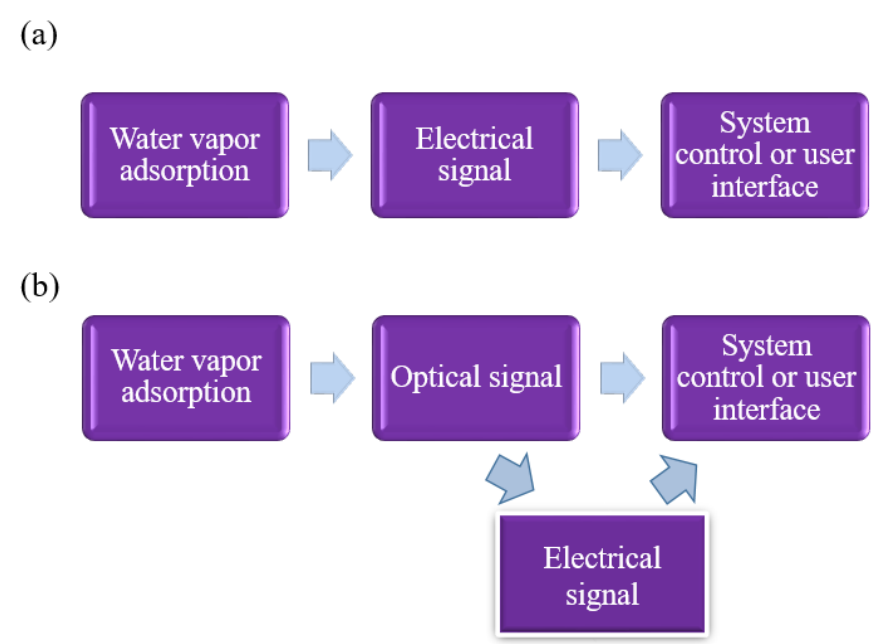
Figure 3. ( a ) The electrical humidity-sensor signal transfer diagram and ( b ) the optical humidity-sensor signal transfer diagram.